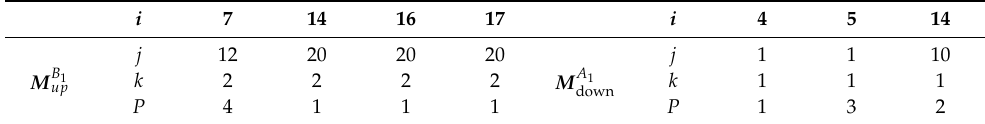
Table 5. Scheduling tasks of Elevator-AB in the second half